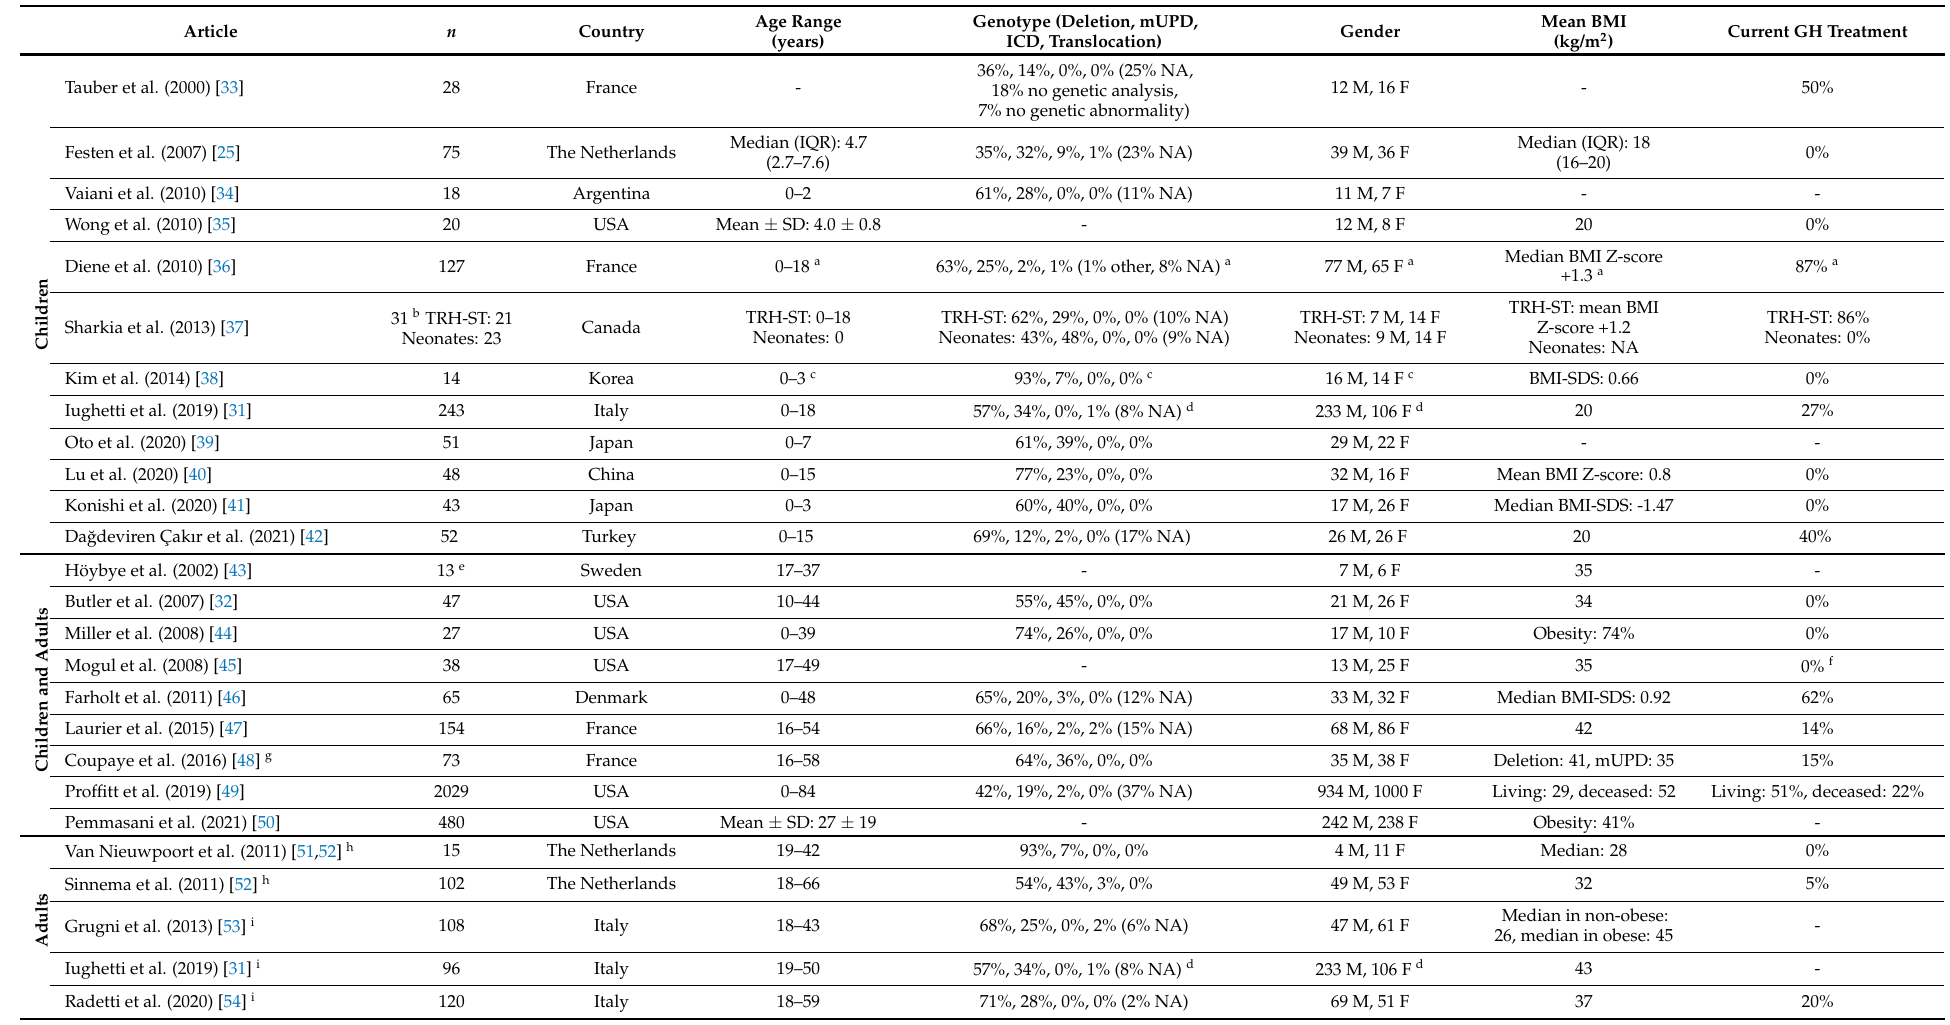
Table 5. Patient characteristics of cohorts assessed by previous studies (Part